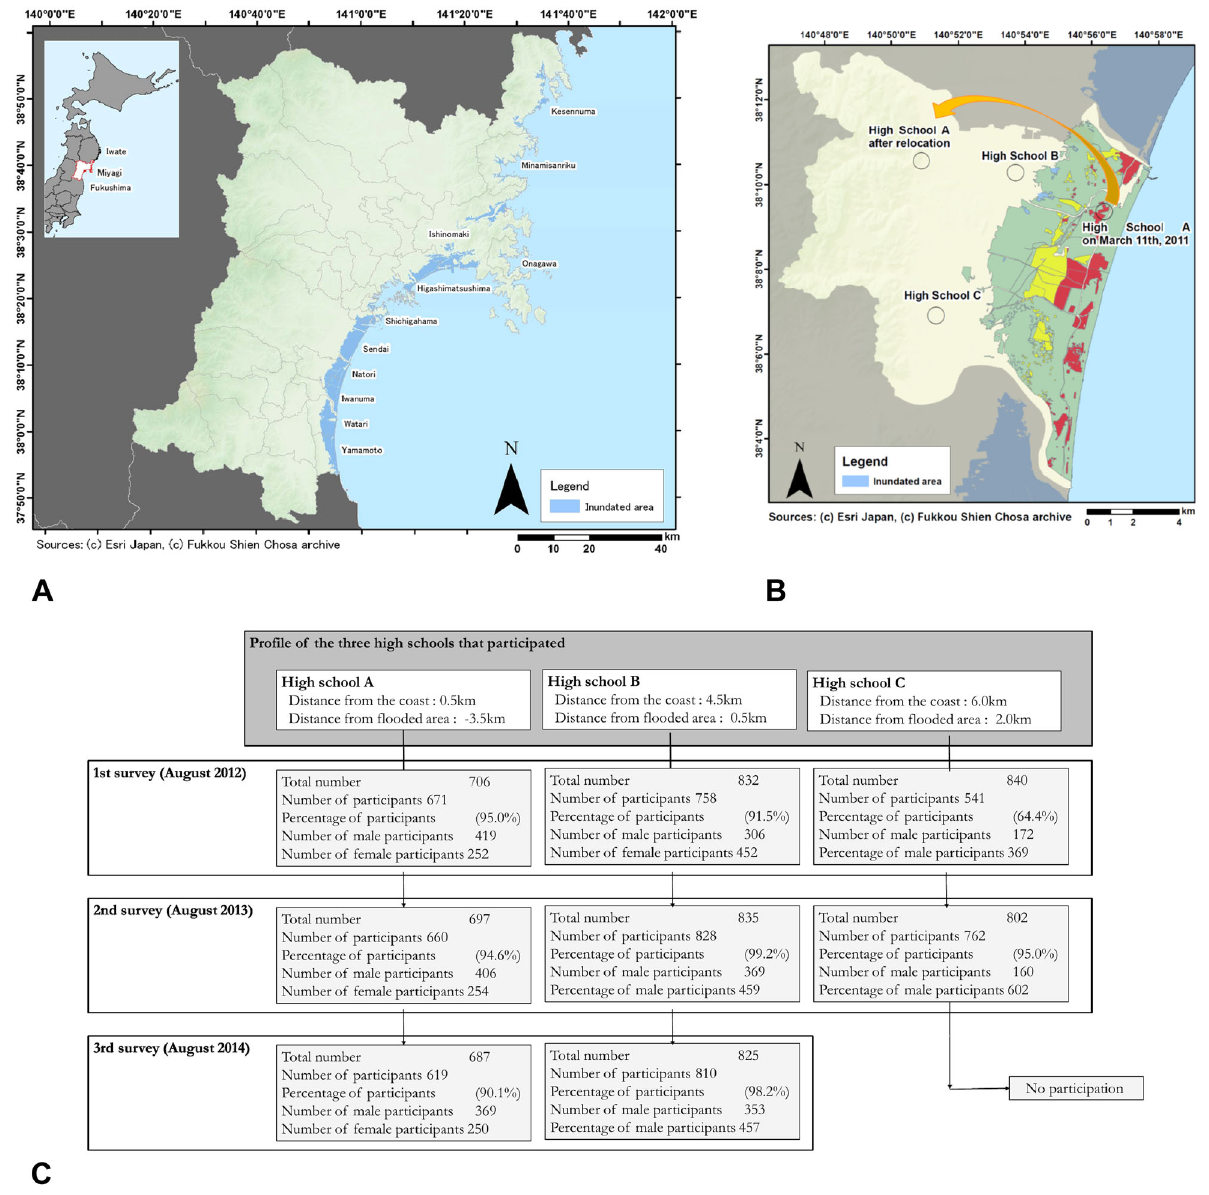
Fig. 2 Longitudinal study of high-school students in the 3 years following the Great East Japan Earthquake. A Flooded areas in Miyagi Prefecture by the Great East Japan Earthquake tsunami. B Flooded areas in Miyagi Prefecture by the Great East Japan Earthquake tsunami. C Survey timing and number of participants from the three high